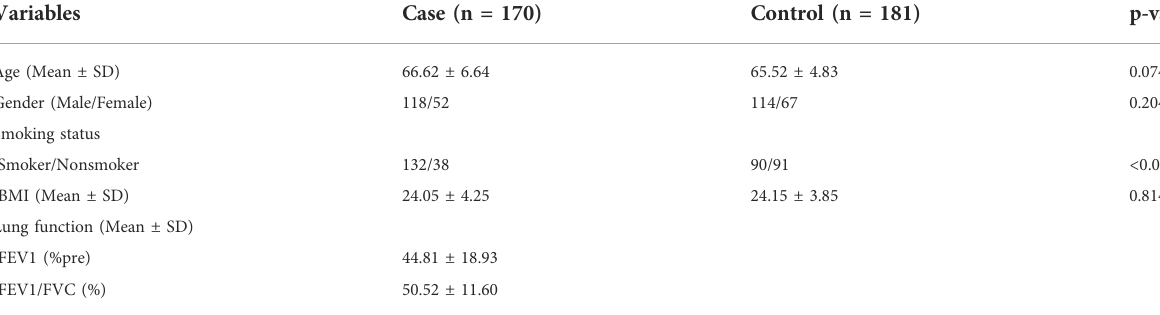
TABLE 2 Characteristics of cases and controls in this study.